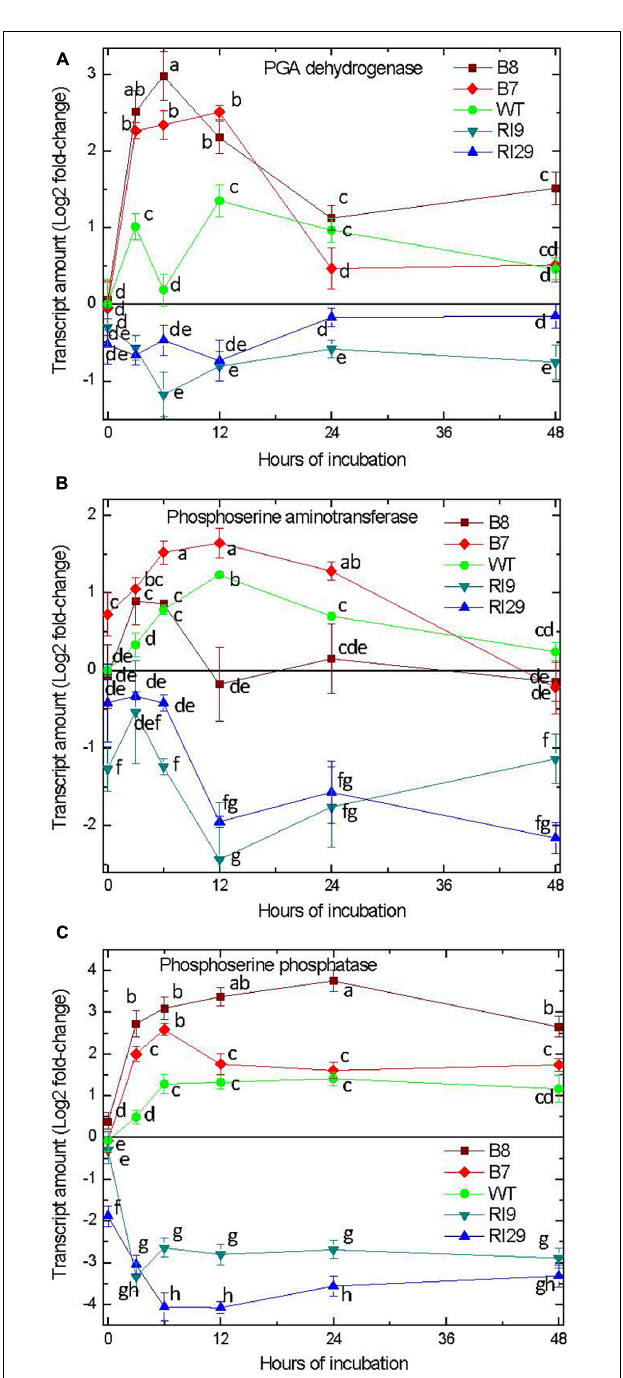
FIGURE 3 | Leaf transcript amount for enzymes of the phosphorylated pathway of serine biosynthesis, including 3-phosphoglycerate dehydrogenase (A) , 3-phosphoserine aminotransferase (B) , and 3-phosphoserine phosphatase (C) in tobacco plants with differing amounts of alternative oxidase and exposed to hypoxia at time 0. For 3-phosphoglycerate dehydrogenase (A) and 3-phosphoserine phosphatase (C) the normalized transcript levels are shown using two reference genes, actin and GAPDH. Vertical bars indicate SD from three independent experiments ( n = 3); different letters indicate significant differences between five tobacco lines and the time